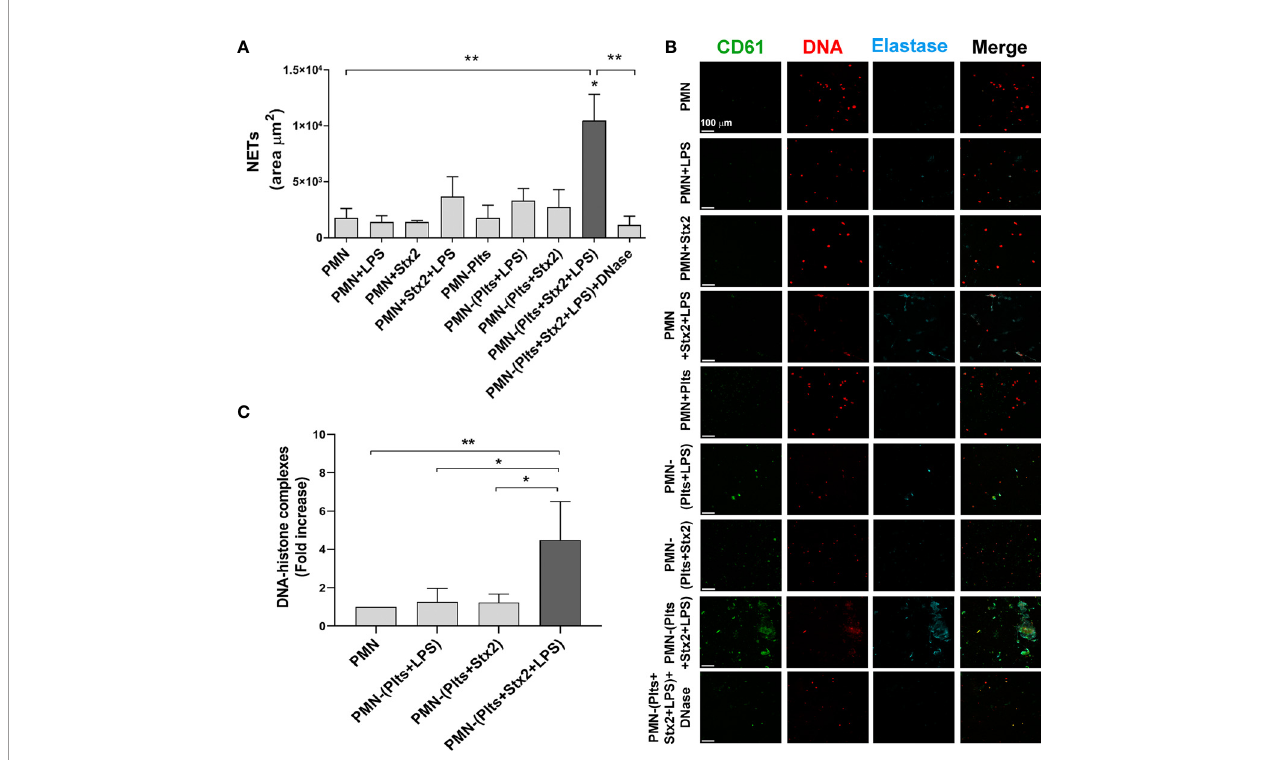
FIGURE 1 | Increased netosis mediated by Stx2 and LPS treated platelets. Plts were left untreated (Plts), treated with Stx2 alone (20 ng ml − 1 ) for 20 min, or treated also with LPS (0.3 µg ml − 1 ) for 20 more min. After that, Plts were carefully washed and incubated with isolated autologous PMN. In addition, PMN were untreated (PMN) or treated directly with LPS and/or Stx2. Samples were seeded on poly-L-lysine treated glasses for 6 (h) (A) Area of NETs (µm 2 ) was determined by fl uorescence microscopy, labeling DNA with propidium iodide (PI), neutrophil elastase with an anti-elastase antibody, and Plts with an anti-CD61 antibody. (n = 5). *p < 0.01 vs. all other groups; **p < 0.005. (B) Micrographs from one representative independent experiment (200x). (C) NETs were also quanti fi ed by ELISA measuring DNA – histone complexes after releasing NETs onto supernatants by DNase controlled digestion. (n = 3). *p < 0.01; **p < 0.005. All results were expressed as the fold increase absorbance relative to unstimulated PMN (mean ±